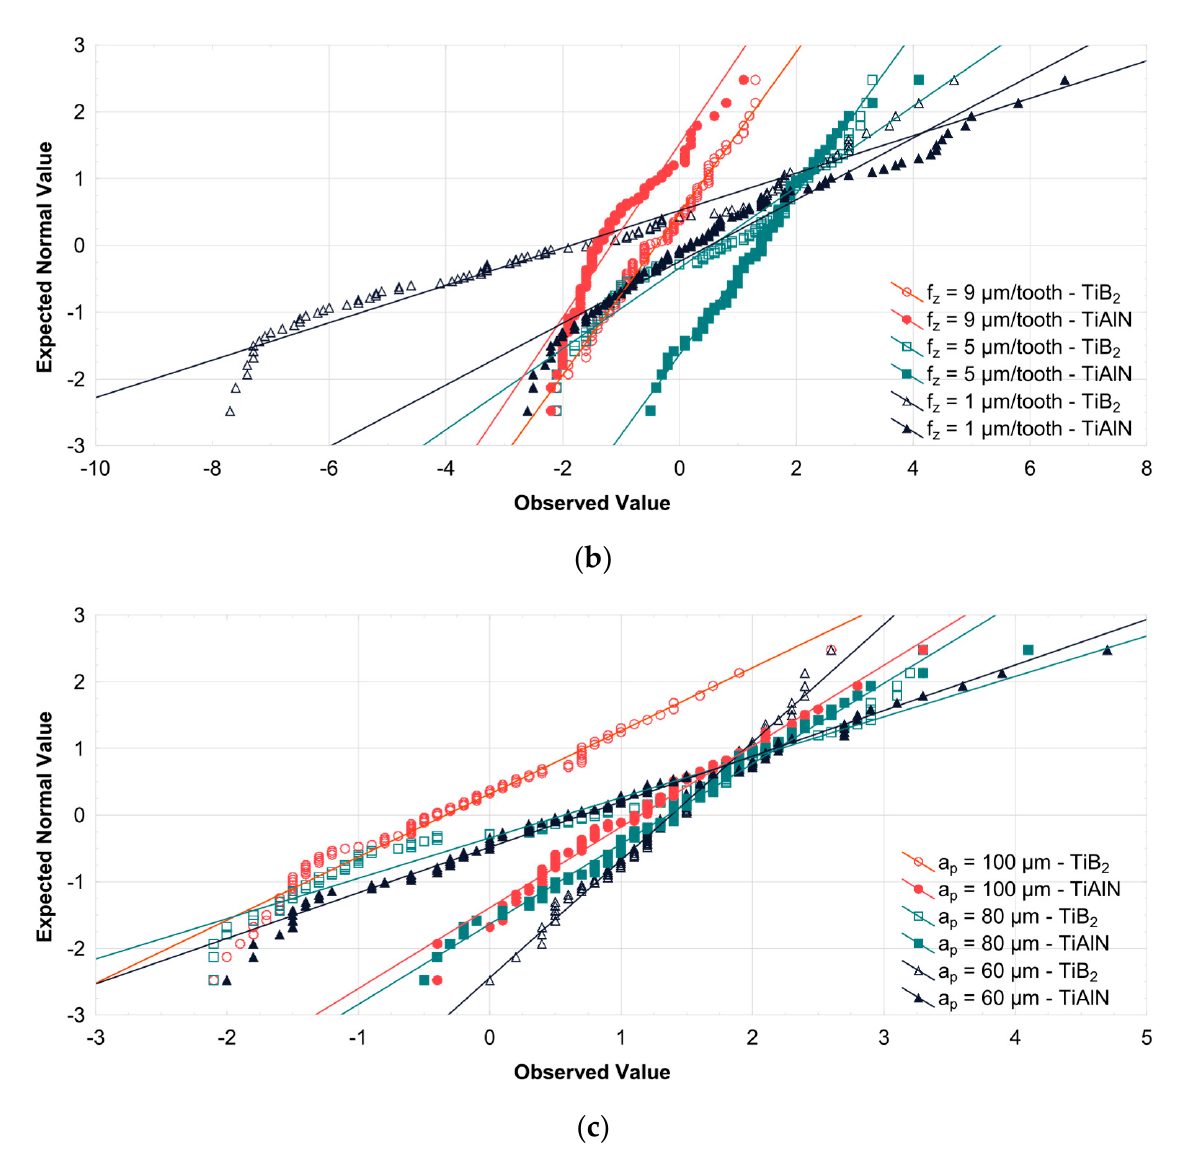
Figure 2. Assessment of data distribution normality using variable ( a ) cutting speed; ( b ) feed per tooth; ( c ) axial depth of cut.